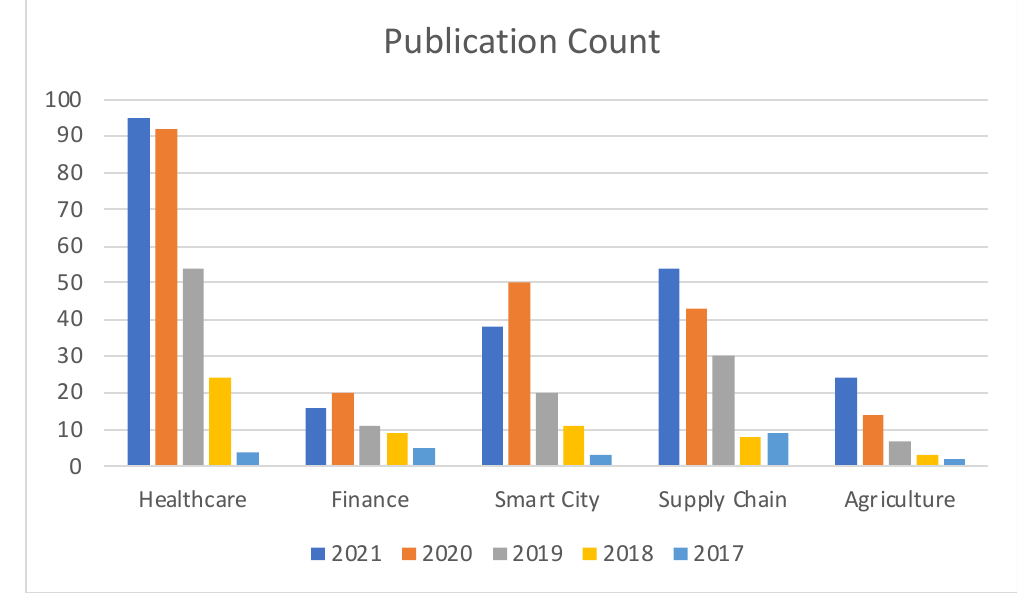
Figure 2. Publication count comparison among application areas.